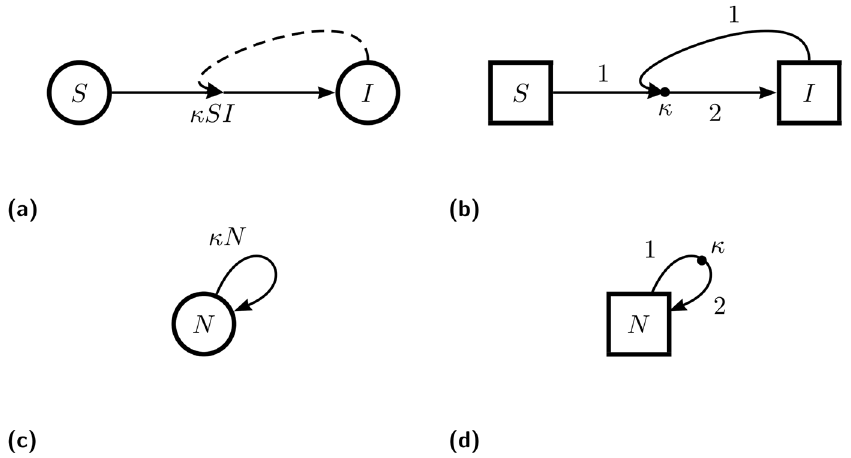
Fig 1. Examples of flow diagrams from two different diagrammatic schema. Diagrams (a) and (b) both represent a simple consumer-resource interaction between a “ susceptible ” species S and an “ infectious ” species I — such as is used in the simplest SI (susceptible-infected) epidemiological models — but do so in different diagrammatic schema. The edge labels in diagram (b) further specify a model in which one parcel each of S and I combine to form two parcels of I . Both diagrams resolve to the ODE system dI / dt = − dS / dt = κ SI . Diagrams (c) and (d) both represent exponential growth for a population of size N , but do so in different diagrammatic schema. The edge labels in diagram (d) further specify a model in which each parcel of N splits to form two parcels of N . Both diagrams resolve to the ODE dN / dt = κ N . Diagrams (a) and (c) are depicted with the widely used schema of [7], conceptually representing different kinds of positive feedback processes, while diagrams (b) and (d) use the schema described in this document ( “ OFFL ” , defined below) and formally represent the routing of parcels of the population through interaction